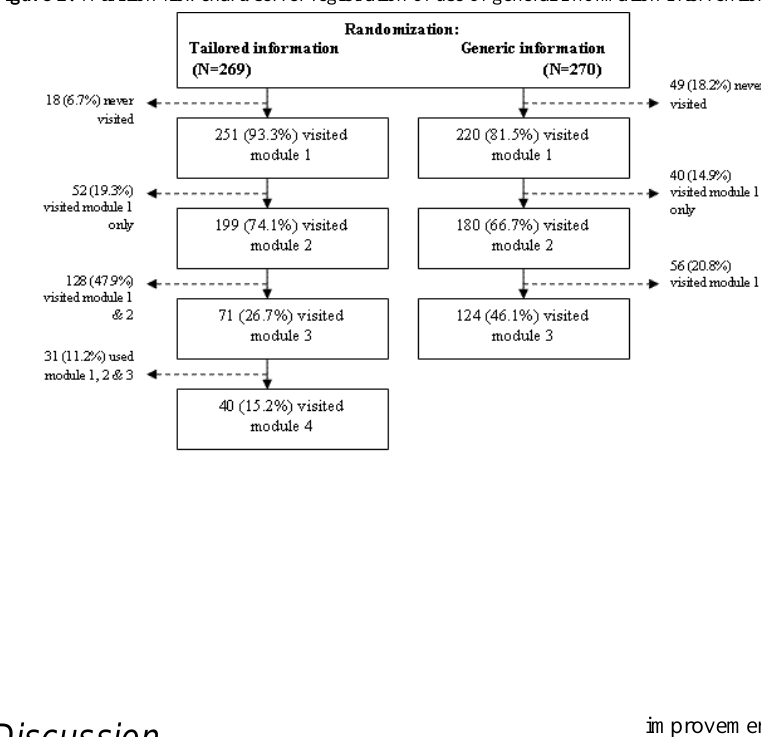
Figure 2. Attrition flowchart: server registration of use of general information intervention and tailored information